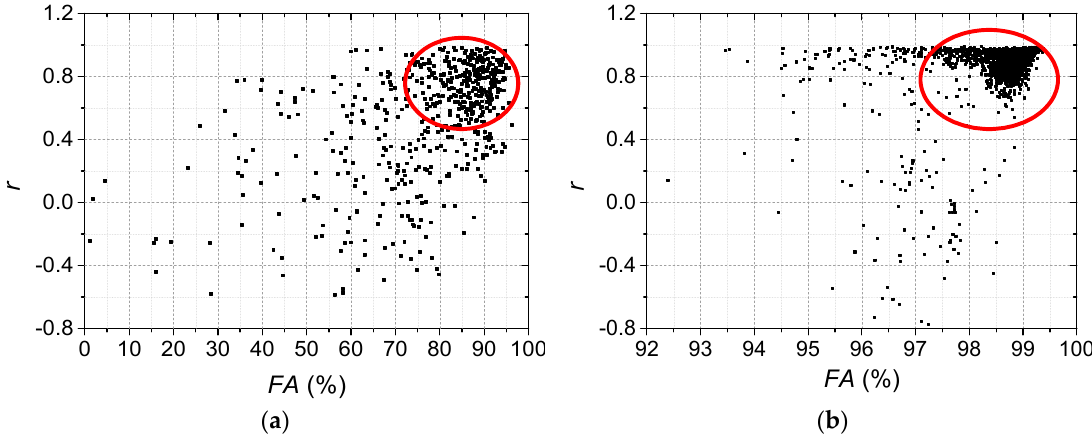
Figure 7. Scatter diagram of forecasting accuracy ( FA ) vs. correlation coefficient ( r ) r . ( a ) The monthly export volume of specifically chosen 31 different kinds of products from January 1995 to December 2018; ( b ) the vibration data of hydraulic test rig with a sampling frequency of 1 Hz during 132,300 s.